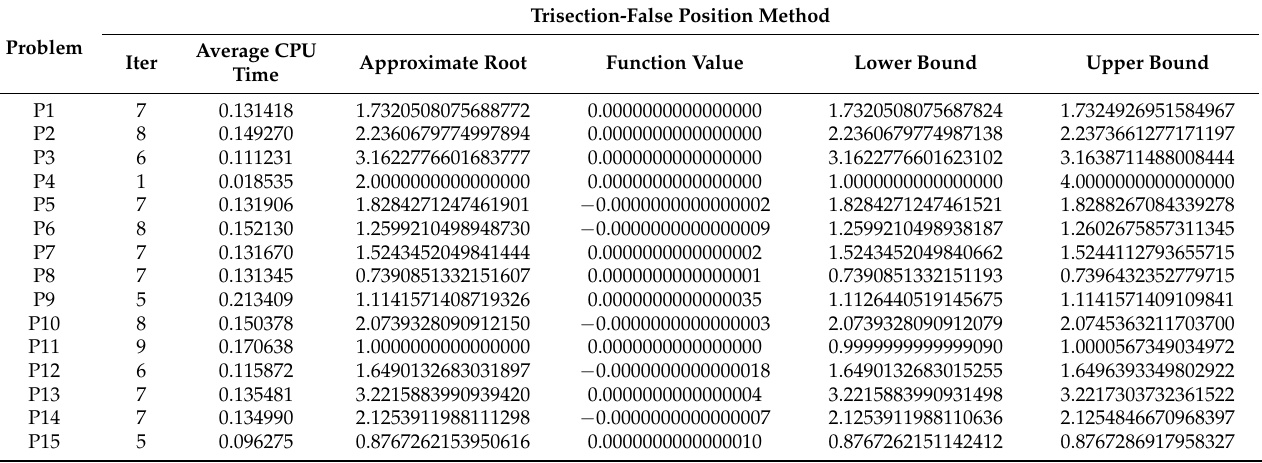
Table 9. Solutions of fifteen problems by the hybrid method trisection-false